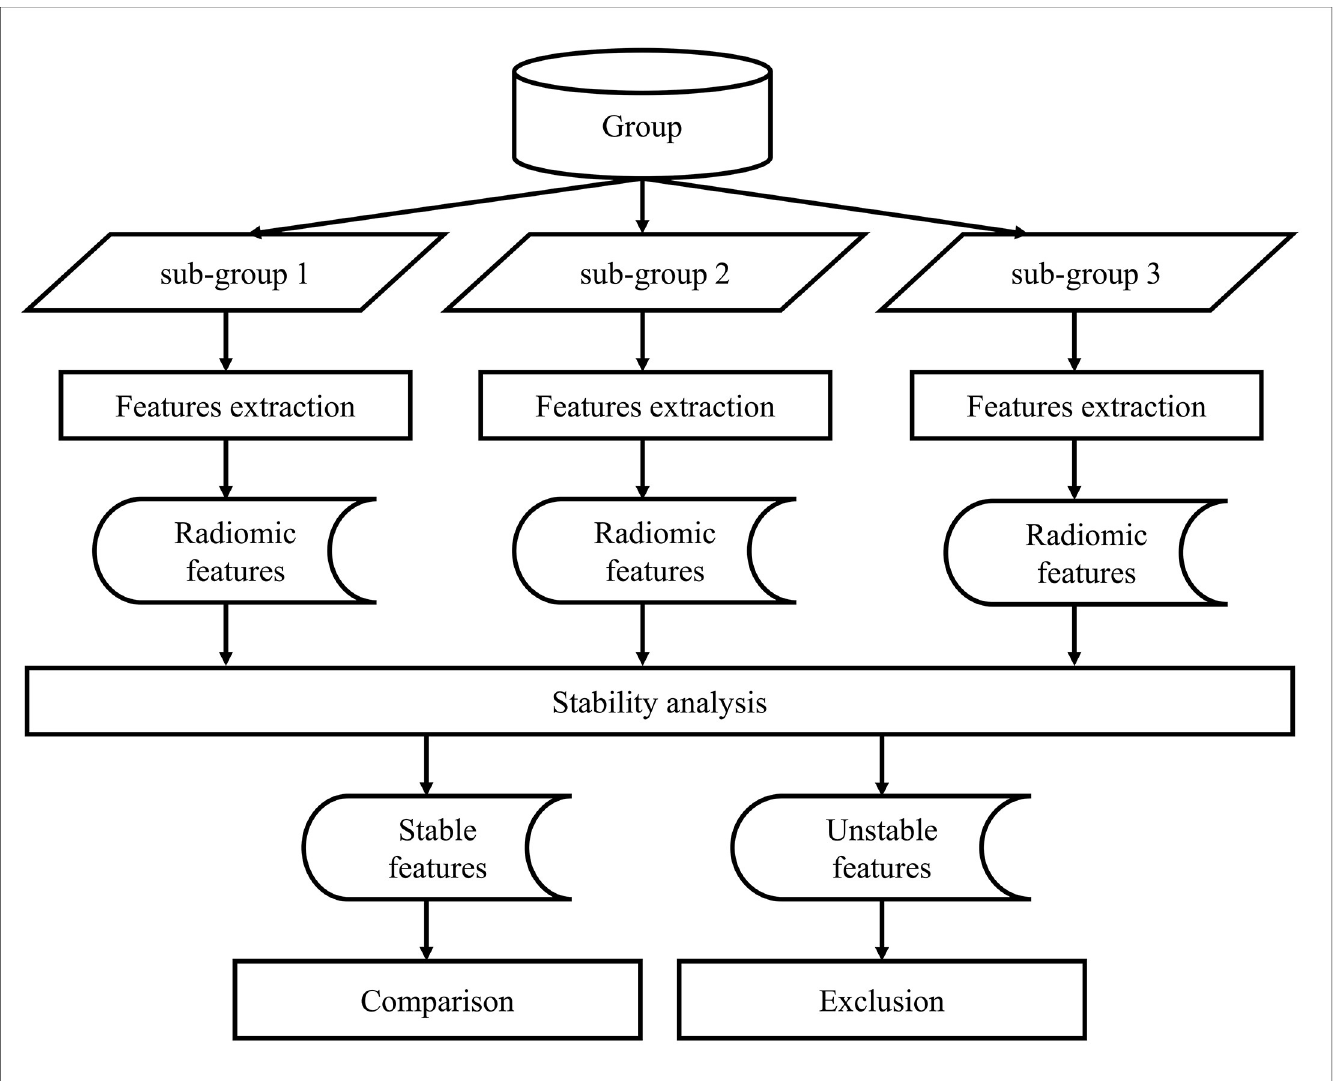
Fig 1. Workflow used for selecting stable radiomic features. The workflow was repeated three times using three different groups (a “mixed group” with contrast and non-contrast enhanced CT images, a “contrast group” with contrast enhanced CT images and a “non-contrast group” with non-contrast enhanced CT images) as input data. The input group was divided in three sub-groups (n = 71 for the mixed group, n = 46 for the contrast group and n = 25 for the non-contrast group) and processed to extract the features. Stable features, identified as the ones with similar distributions among the sub- groups, were further analysed. Feature with different distributions among sub-group (identified as unstable) were not further